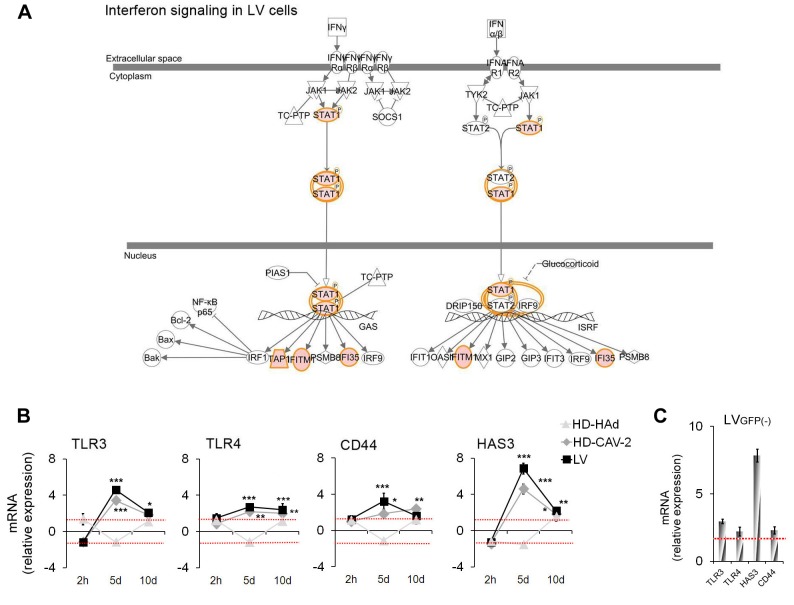
IFN and TLR genes in transduced cells.(a) IFN pathway in LV cells at 5 days posttransduction. In red are highlighted the upregulated genes, in green the downregulated ones, in white genes not modulated in the chip; IPA p-value: 3.56×10−2. Detailed legend is in figure 4c. (b–c) Single gene alterations evaluated by qPCR at 2 h, 5 and 10 days posttransduction for HD-hAd, HD-CAV-2 and LV (b), and at 5 days for LVGFP(-). (c). Red dashed lines display the threshold set at ±1.5, as for microarray data. Data are presented as fold change expression of each transcript normalized with respect to the endogenous control and calculated as compared to the mock sample considered as 1. Data are reported as mean of three independent experiments with SD; one-way ANOVA (vectors versus mock); * p<0.05, ** p<0.01, ***p<0.001.